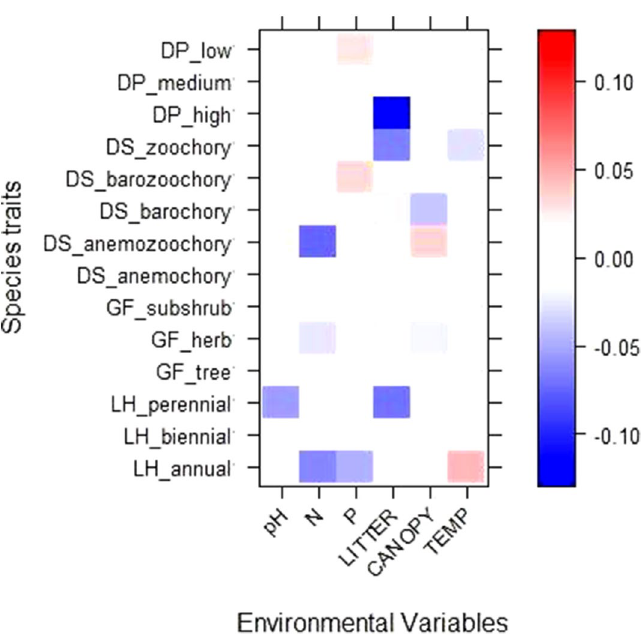
Figure 4. Results of fourth-corner modelling for plant trait interactions with environmental changes that occur along eucalypt forest cycle. Red represents a positive association and blue a negative association. Color grading show the direction and strengths of standardized coefficients of fourth-corner models for all environment/trait interaction terms from GLM-LASSO modelling. LH = life history, GF = growth form, DS = dispersal syndrome, DP = dispersal potential. CANOPY = canopy cover, LITTER = leaf litter depth, P = phosphorus content in soil, C = carbon content in soil, N = nitrogen content in soil, TEMP =